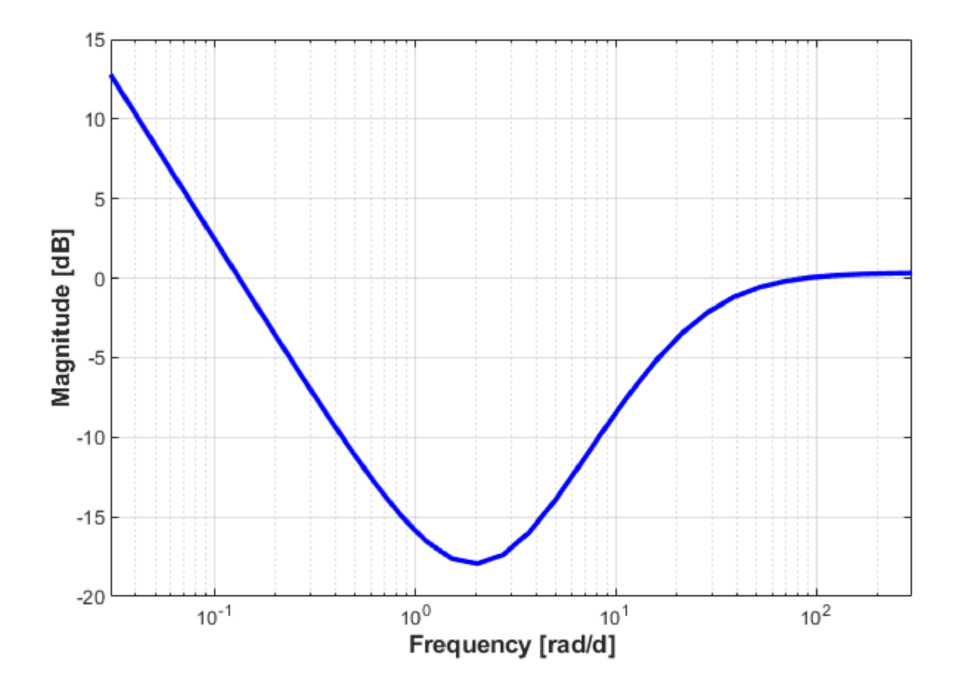
Figure 11. The Bode characteristics of the controller achieved through the IMC control